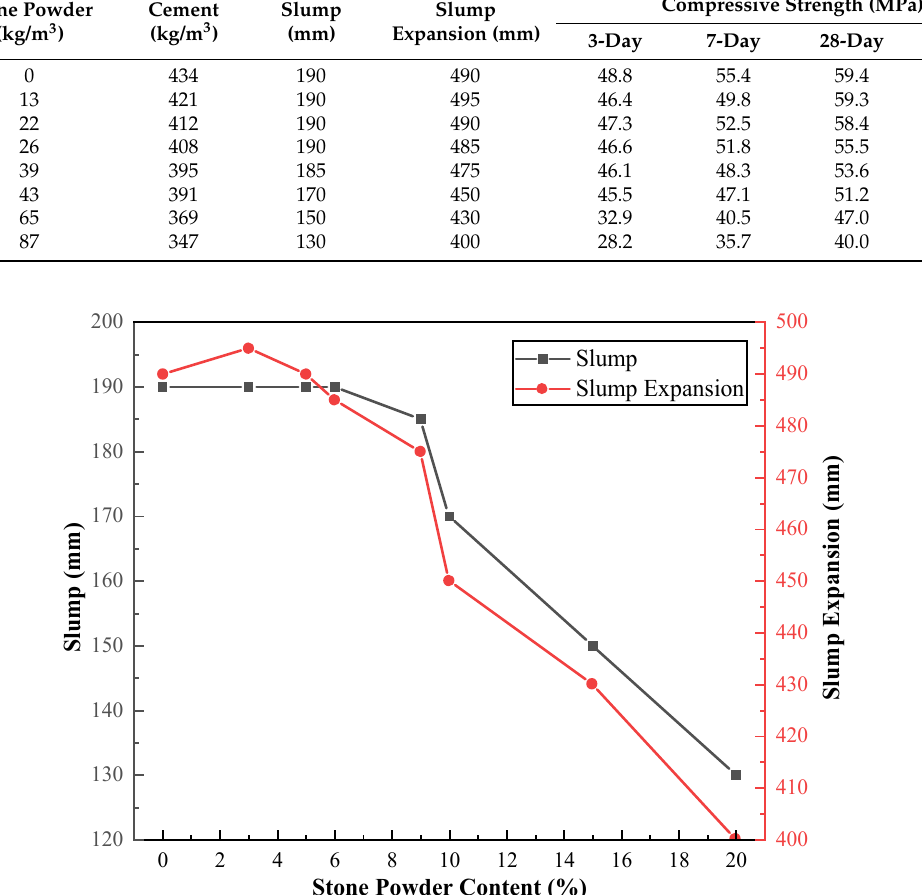
Figure 6. Concrete slump and slump expansion versus stone powder content curve.